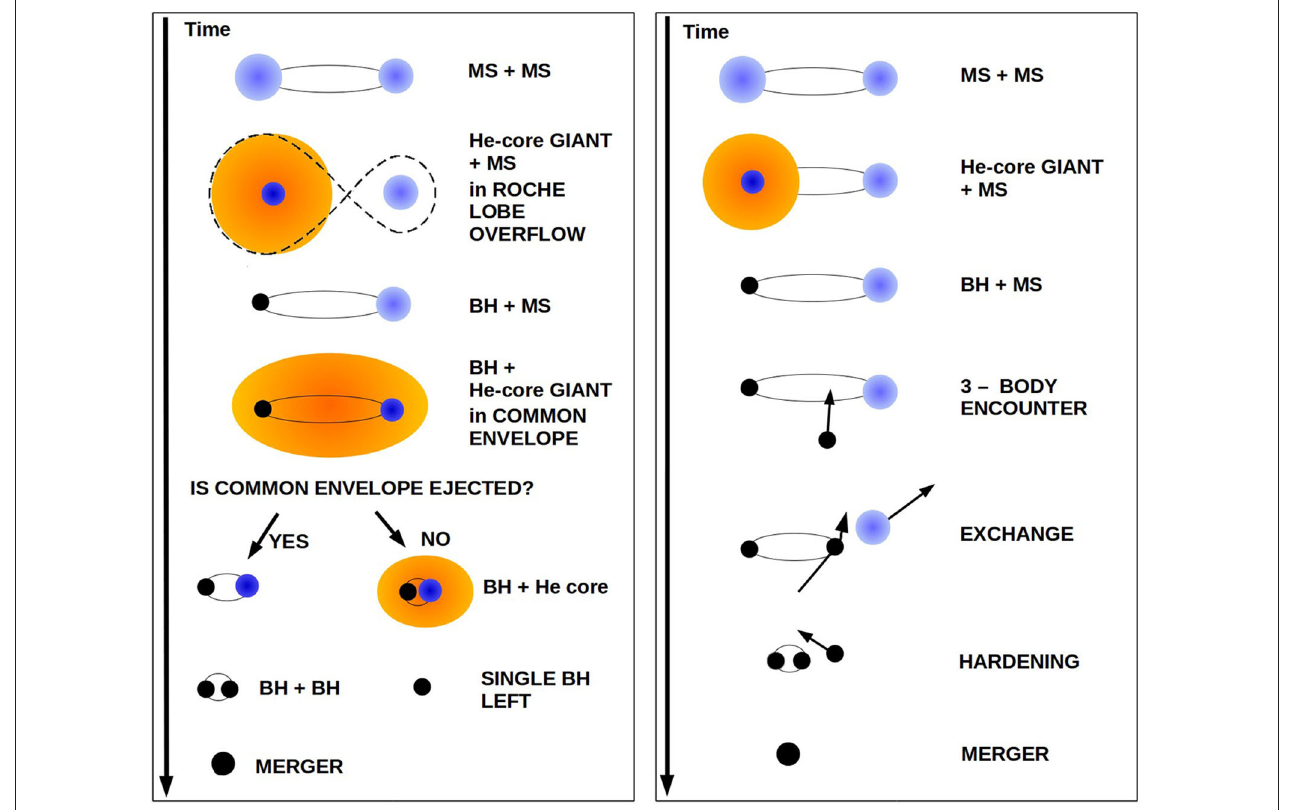
FIGURE 2 | Left: cartoon of isolated BBH formation through common envelope; Right : cartoon of dynamical BBH formation in star